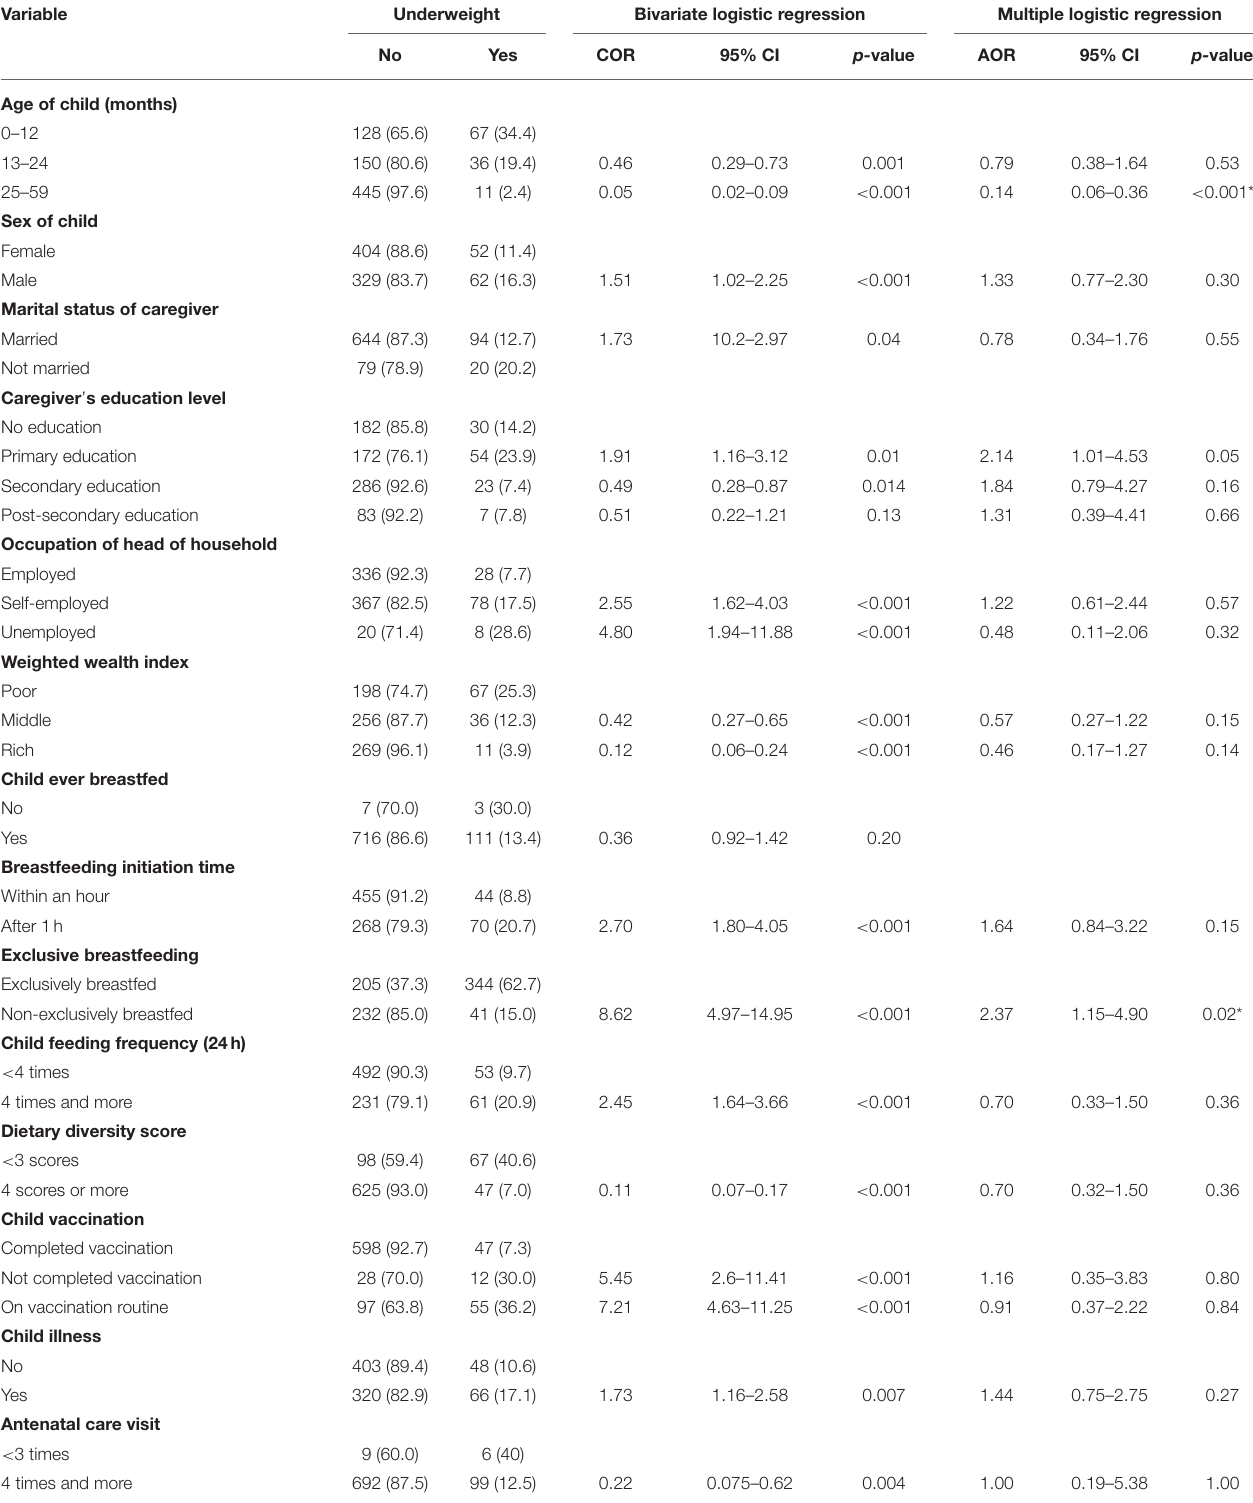
TABLE 4 | Bivariate and multiple logistic regression for factors associated with underweight (WAZ < − 2SD) among children age 0–59 months in Bambao region, July 2021 ( N = 837). Variable Underweight Bivariate logistic regression Multiple logistic